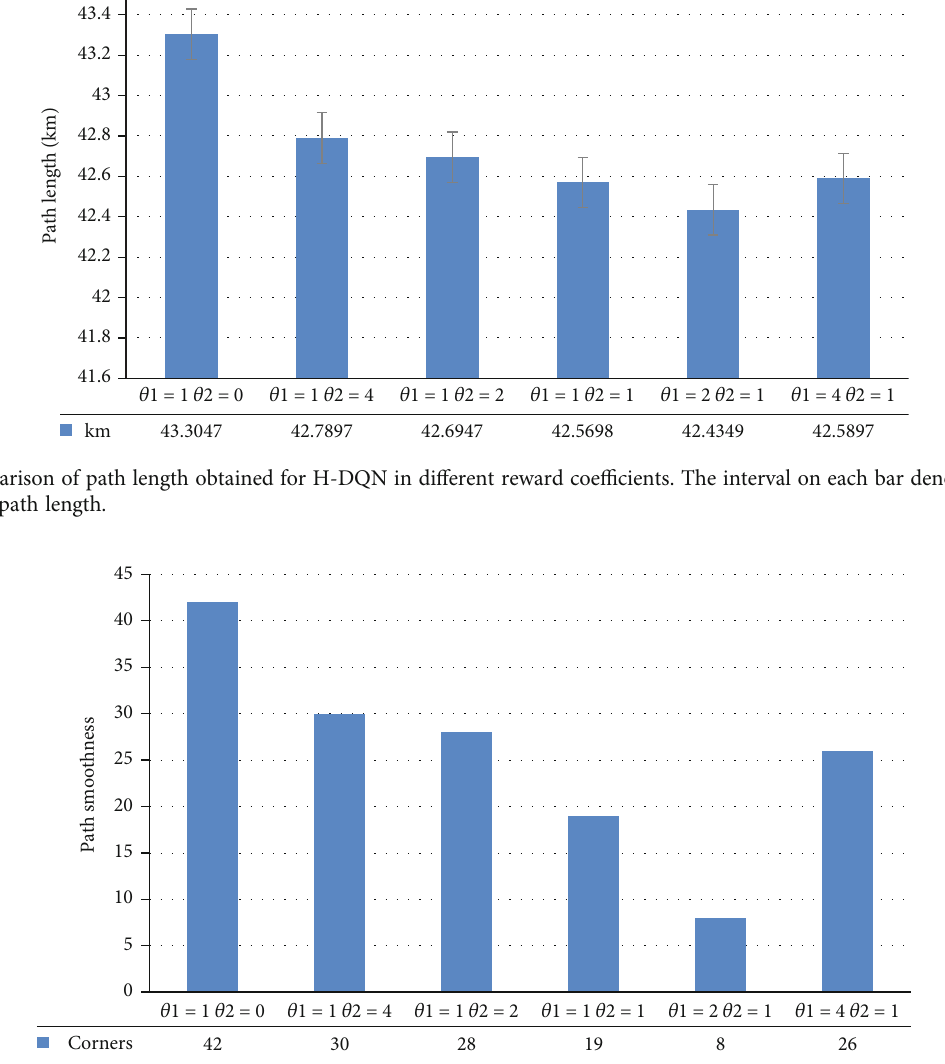
Figure 9: Comparison of path smoothness obtained for H-DQN in di ff erent reward coe ffi